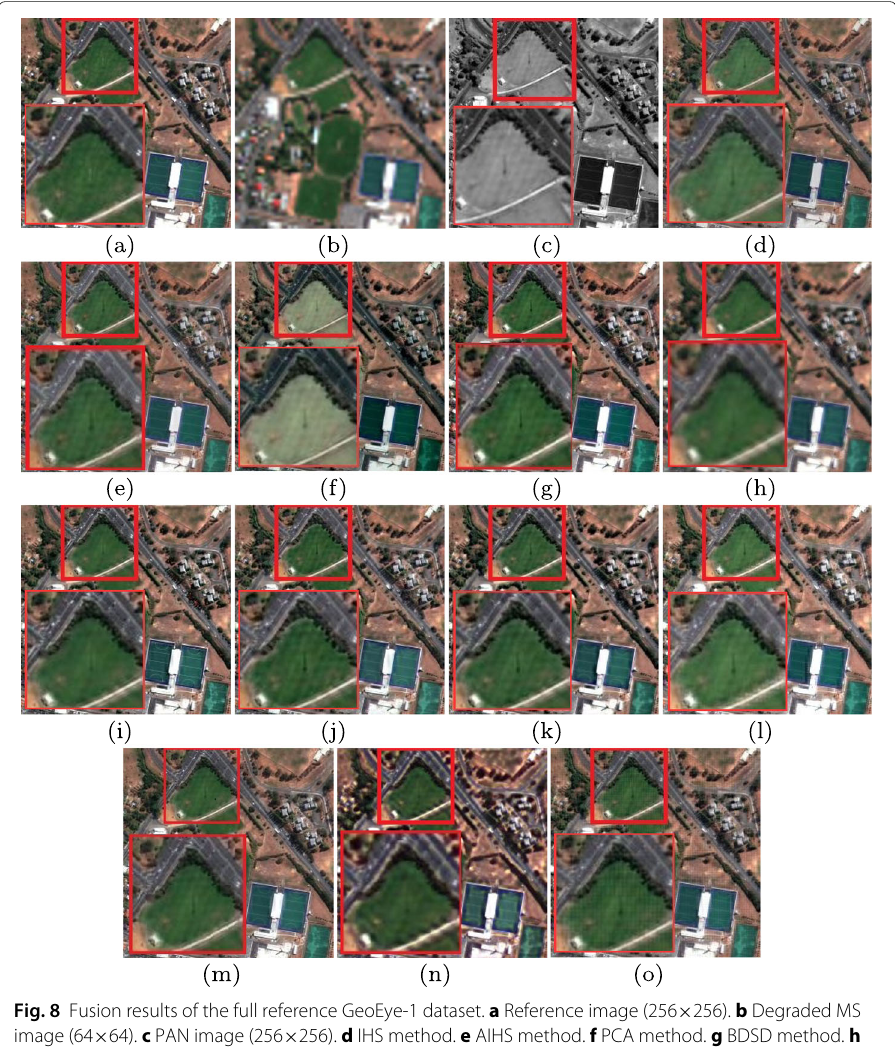
Fig. 8 Fusion results of the full reference GeoEye-1 dataset. a Reference image (256 × 256). b Degraded MS image (64 × 64). c PAN image (256 × 256). d IHS method. e AIHS method. f PCA method. g BDSD method. h